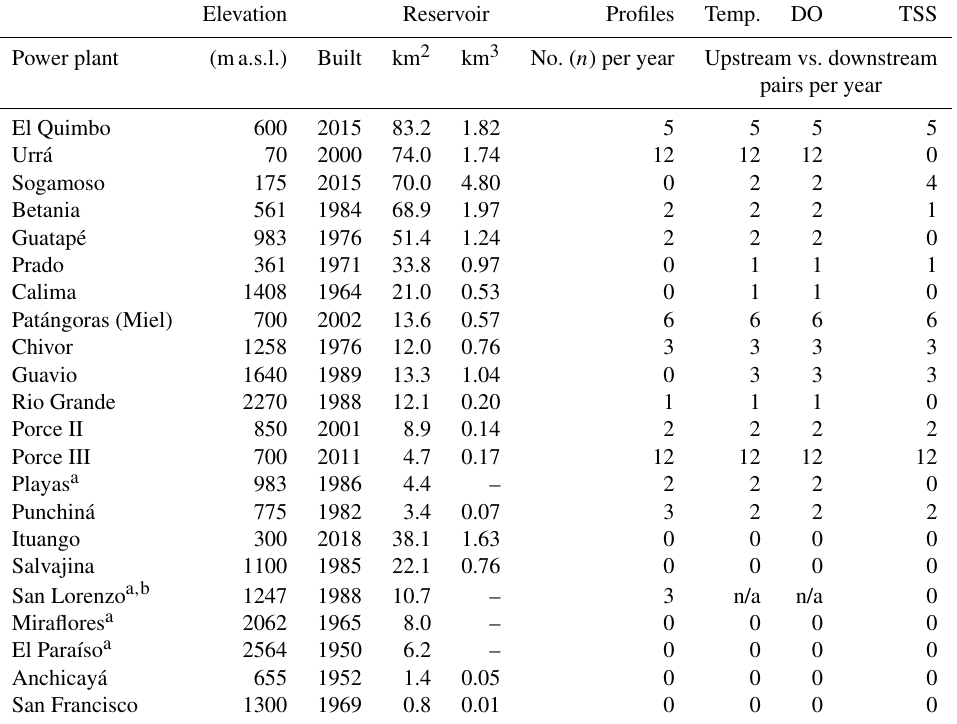
Table 1. Summary of the data available (in samples per year) for the assessment of reservoir stratification (no. of profiles), changes in river temperature, dissolved oxygen (DO) and total suspended solids (TSS) caused by dams for all hydropower stations licensed by the Autoridad Nacional de Licencias Ambientales (ANLA) in Colombia. Power plants with data for upstream vs. downstream comparisons are listed first and sorted by surface